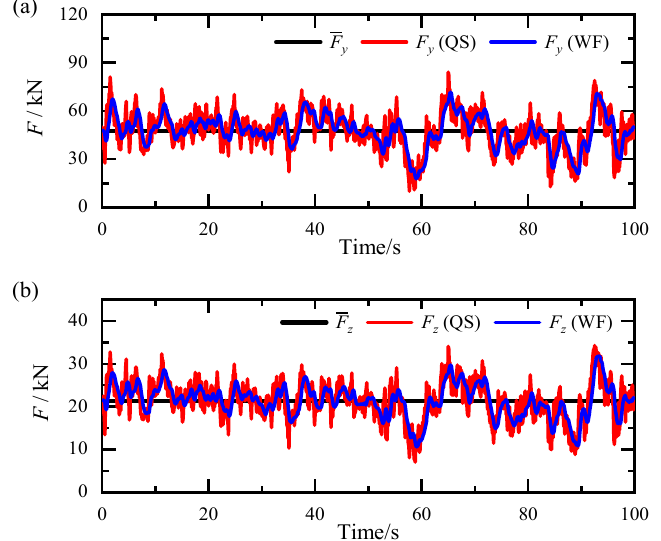
Figure 19. Simulated unsteady aerodynamic forces time histories ( U = 20 m/s, α = 90 ◦ , V = 300 km/h, V R = 85.7 m/s, β = 13.5 ◦ ): ( a ) side force; ( b ) lift force.